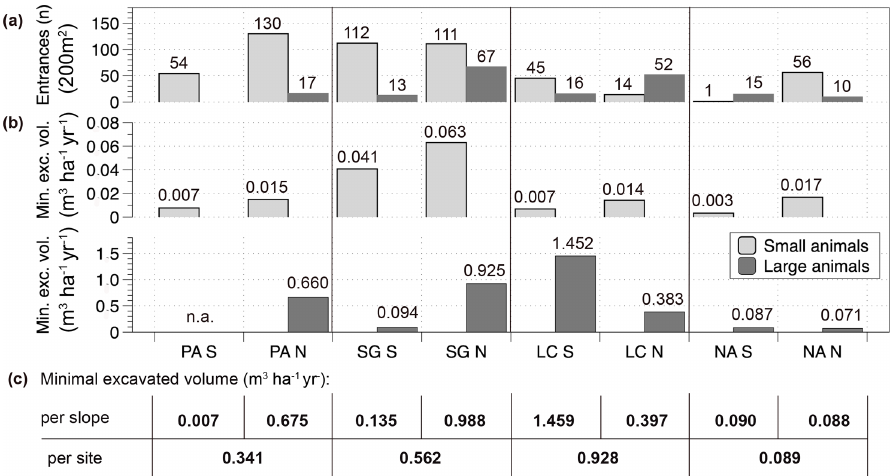
Figure 7. Burrow entrance numbers and minimum excavated volumes per slope in an arid to humid–temperate climatic gradient. (a) Quantity of burrow entrances by animals separated by site, slope and animal group (large and small animals), n of entrances are sums of two plots per slope (composed of 2 10m × 10m plots, total surface 10 × 20m 2 ); (b) minimum excavated volume of plots upscaled to m 3 ha − 1 yr − 1 separated by slope; (c) Minimum excavated volume amounts per slope and site summed for all animals; the figure is based on the data of the 2018 field campaign. PA – NP Pan de Azúcar, SG – Santa Gracia, LC – NP La Campana, NA – NP Nahuelbuta, S – south-facing, N – north-facing, n.a. – not applicable. (Note that in PA the sum of the south-facing plot entrances is one plot, and the north-facing entrance sum is three plots.)